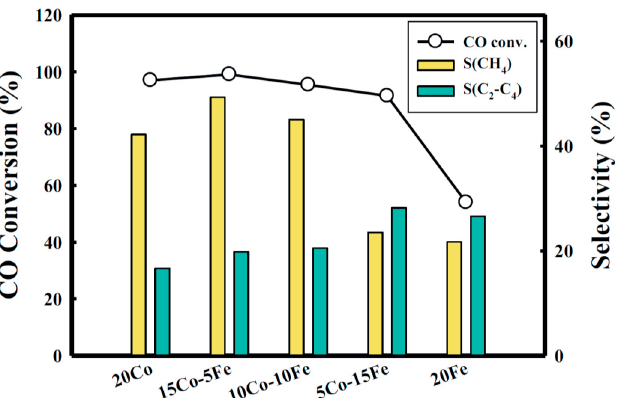
Figure 16. CO conversion and selectivity of CH 4 and C 2 –C 4 hydrocarbons with various content.